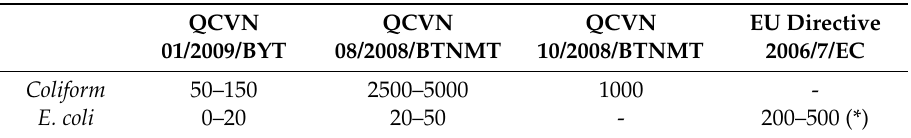
Table 5. Water quality standard for different purposes (MPN/100